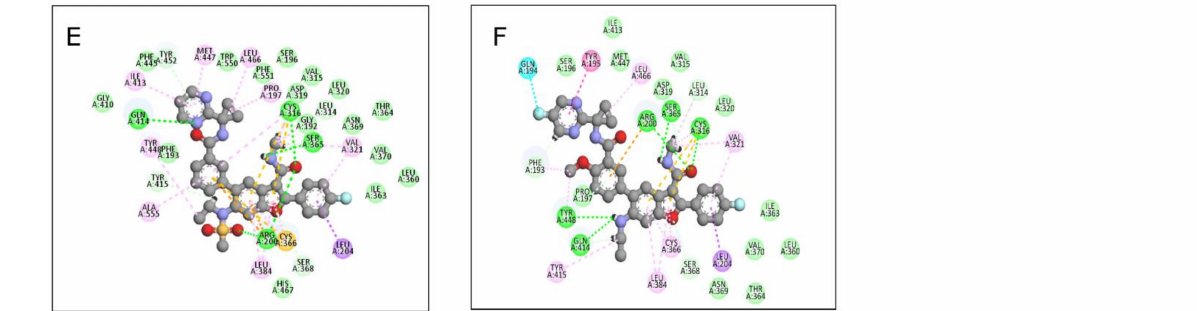
Figure 11. The HCV RdRP–inhibitor complexes showing the interactions of different residues with the bound inhibitor: ( A ) compound 25 (PDB 6MVK), ( B ) compound 45 (PDB 6MVP), ( C ) compound 31 (PDB 6MVQ), ( D ) compound 49 (PDB 6MVO), ( E ) compound 5 (PDB 5QJ0), and ( F ) compound 13 (PDB